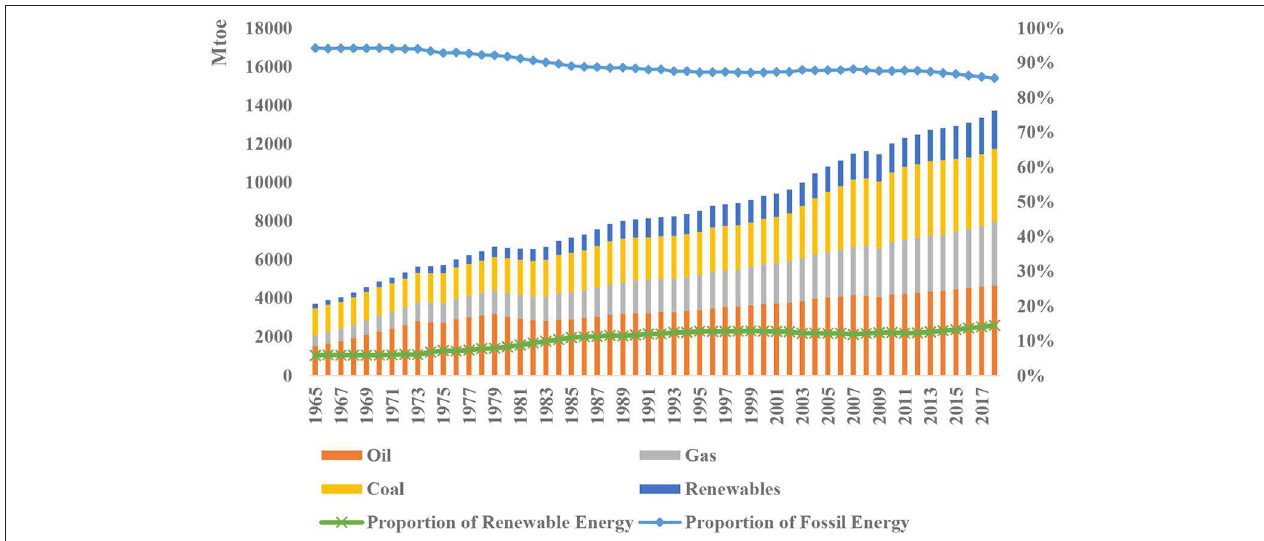
FIGURE 1 | Evolution of global energy mix consumption and ESC structure Note: (Left Axis refer to the unit of Mtoe; Right Axis refer to the unit of percentage) Source: BP (2019).